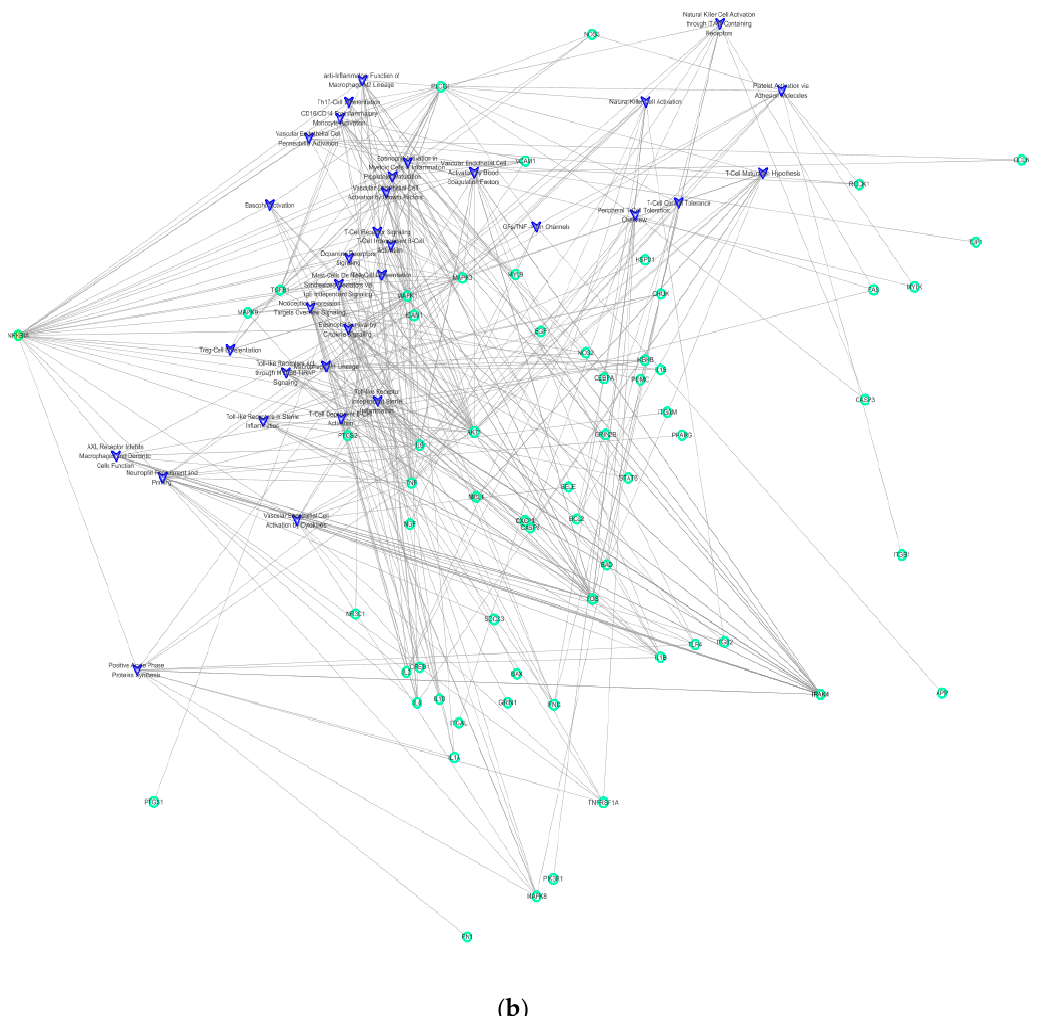
Figure 4. Target-pathway network. ( a ) Panax ginseng and ( b ) Red ginseng. Targets (green) and pathways (blue). Cytoscape file was included as supplementary information (Figures S1 and S2).